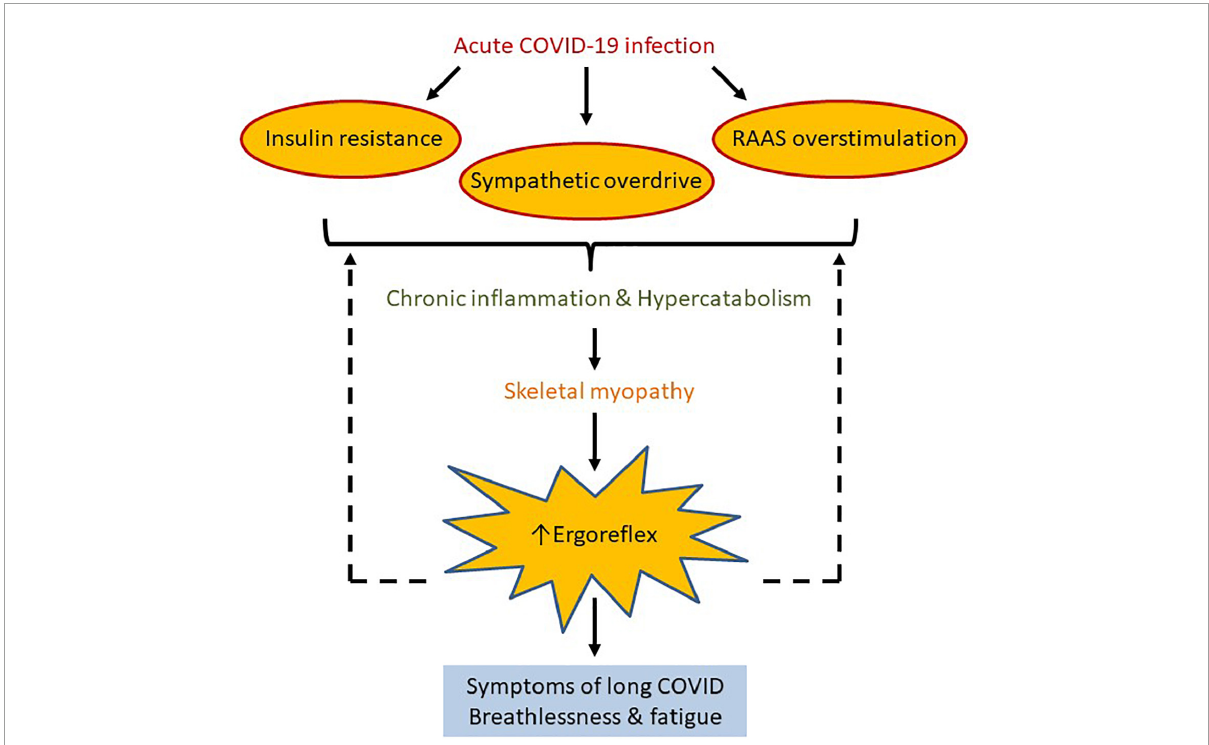
FIGURE3 We propose ergoreflex overstimulation as a possible pathophysiological mechanism of long COVID. Acute COVID-19 infection predisposes to insulin resistance and sympathetic and renin-angiotensin-aldosterone system overstimulation, which may lead to chronic inflammation and hypercatabolism. This in turn can cause reduction in skeletal mass and function, which increases ergoreflex sensitivity, and perhaps explains the symptoms of long COVID such as breathlessness and fatigue. Solid and dotted arrows represent known and hypothetical relations,